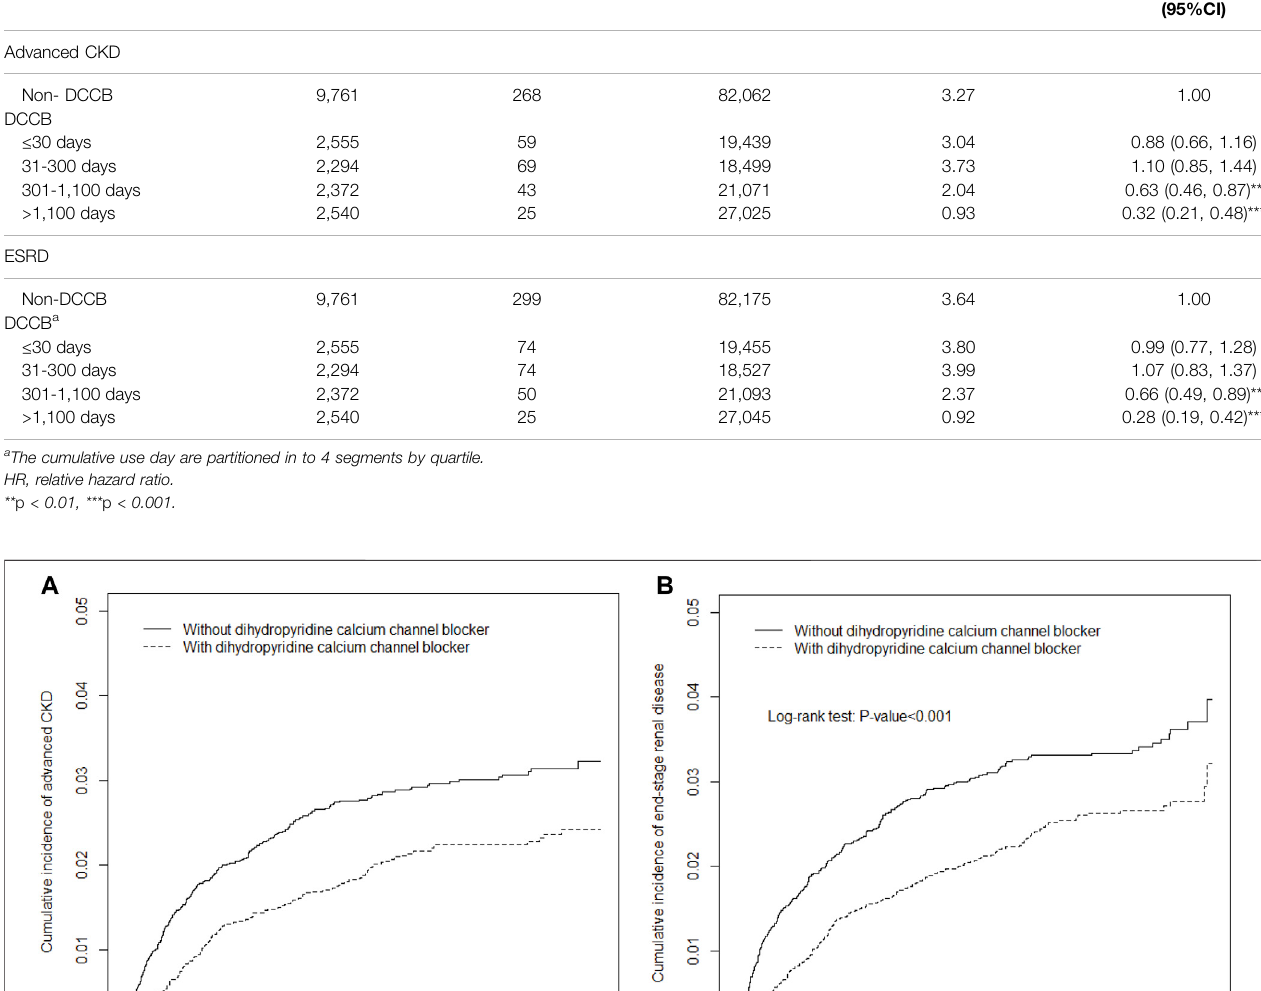
TABLE4| Incidenceandadjustedhazardratioofadvanced CKDorESRDstrati fi edbydurationofdihydropyridinecalciumchannelblocker(DCCB) therapyamongdiabetes mellitus patients with chronic kidney disease. Medication exposed